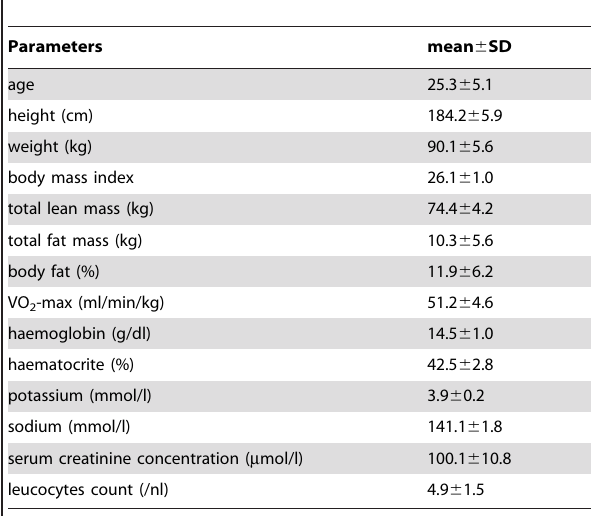
Table 1. Baseline characterisation of